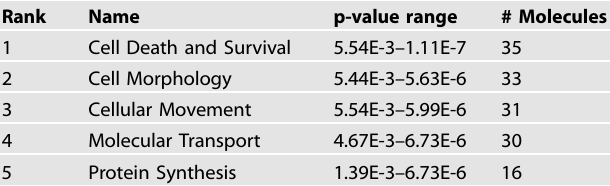
Table 1. Top 5 molecular and cellular function annotations of IPA disease and function based on 73 ONC-responding genes of affected in Jun − / − mice.